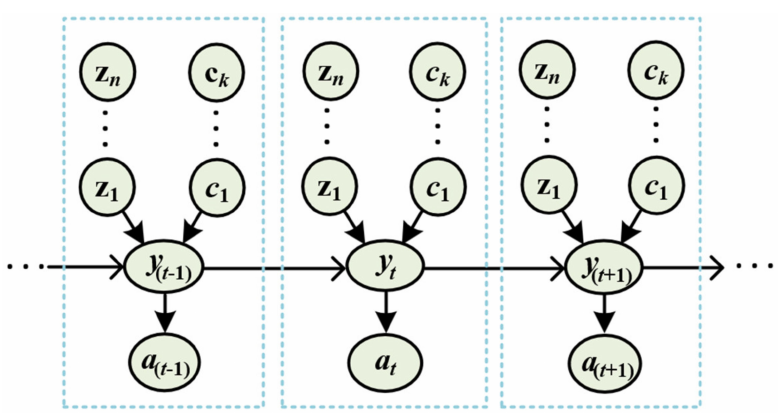
Figure 4. The data flow of the proposed